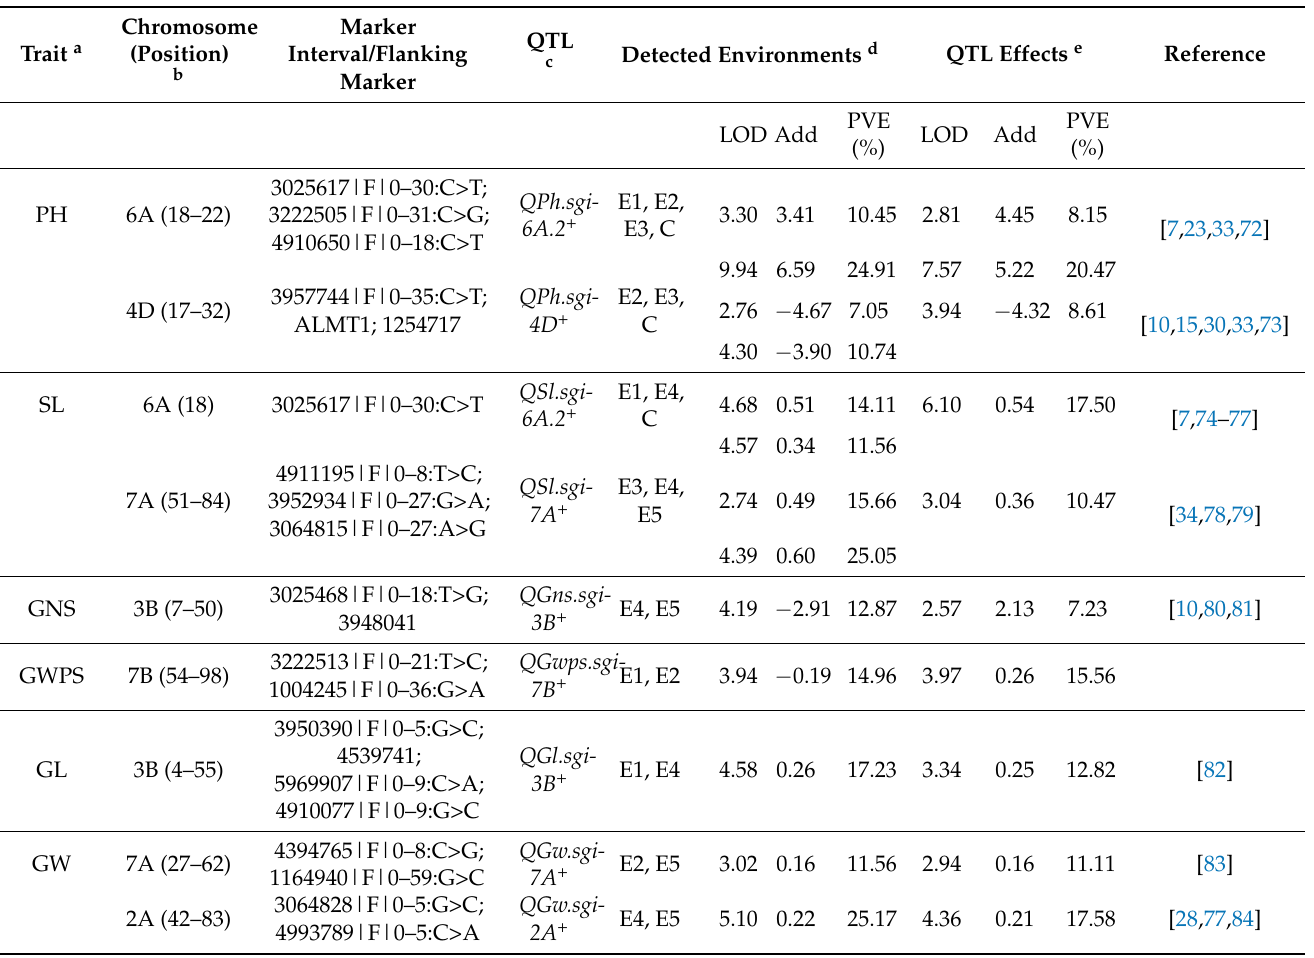
Table 3. QTL detected in two (2) or more environments and/or combined QTL analysis in the Tugela-DN × Elands doubled haploid population for plant height and yield component